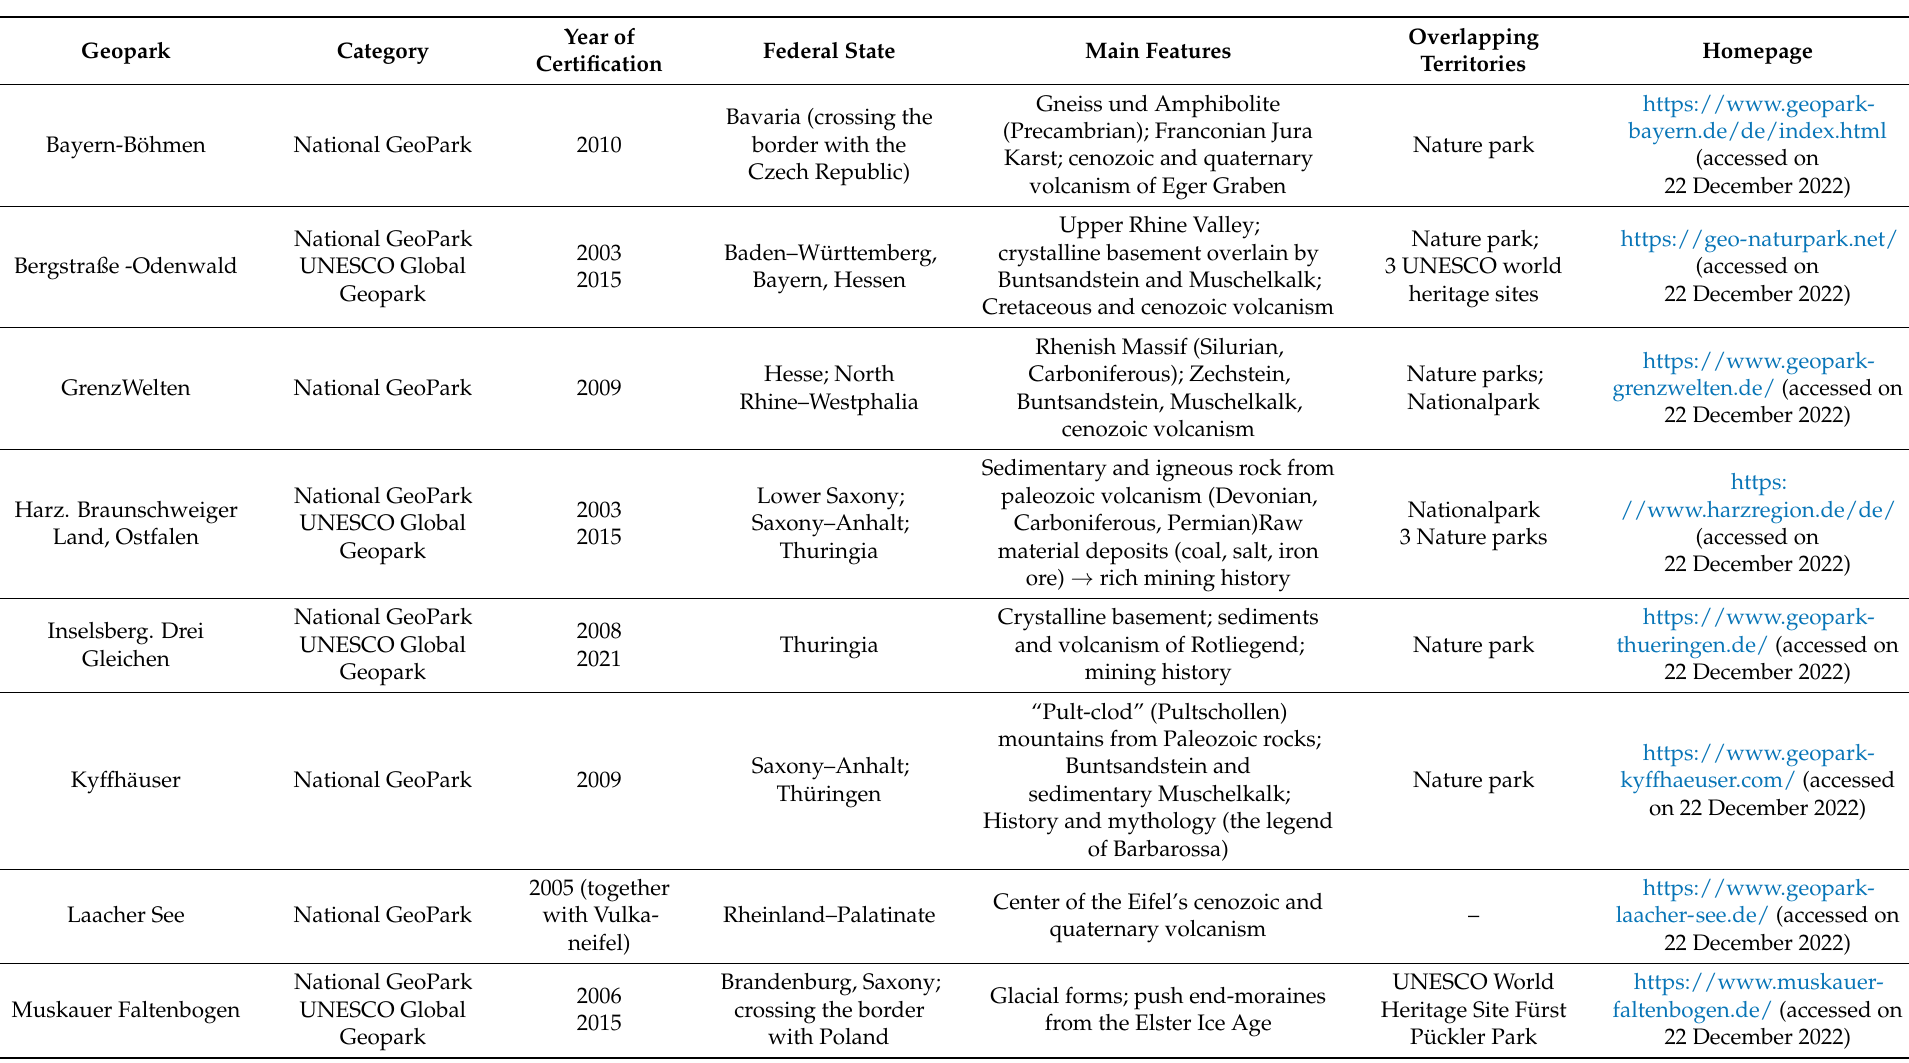
Table 1. Geoparks with certification status in Germany (authors’